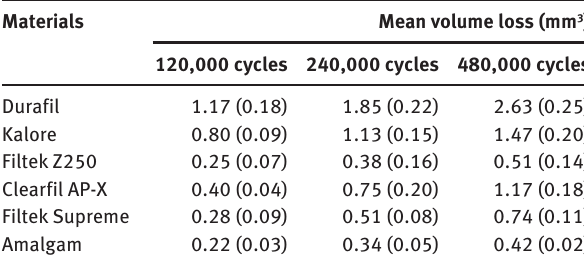
Table 4: Mean volume loss and standard deviations of tested materials different chewing cycles.